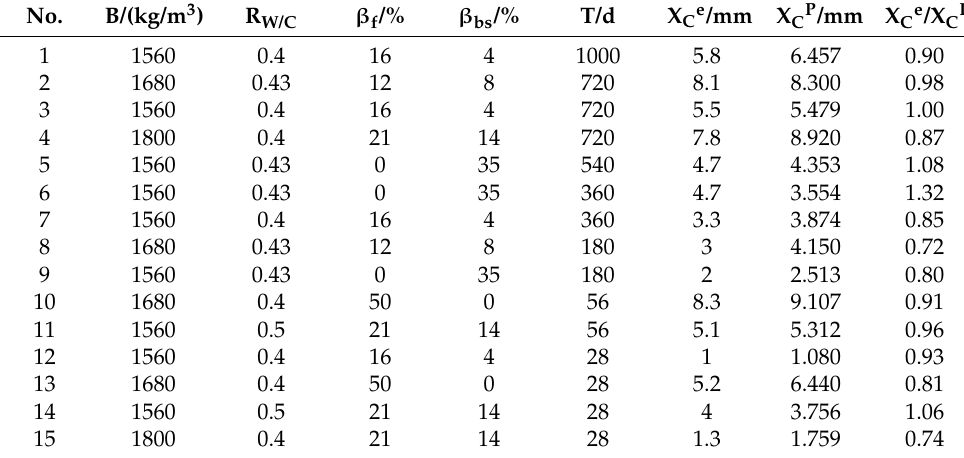
Table 4. Comparisons between calculation values of the prediction model and other experimen- tal